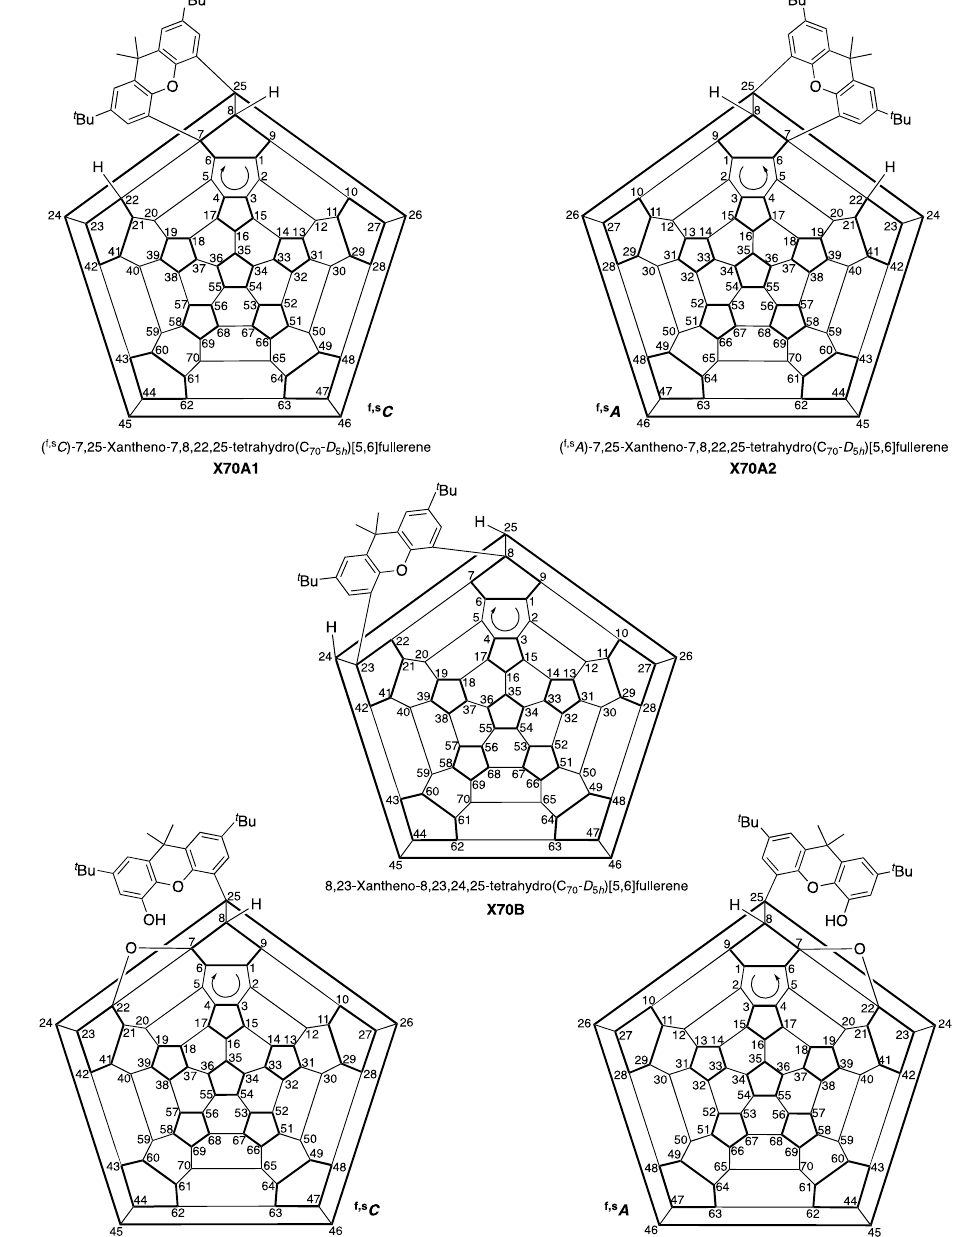
Figure 4. Schlegel diagrams of X70A , X70B , and X70F with enantiomeric numbering schemes: systematic numbering recommended by IUPAC; arrows indicate the direction of the numbering commencement. The full names for these compounds are listed in the Supplementary